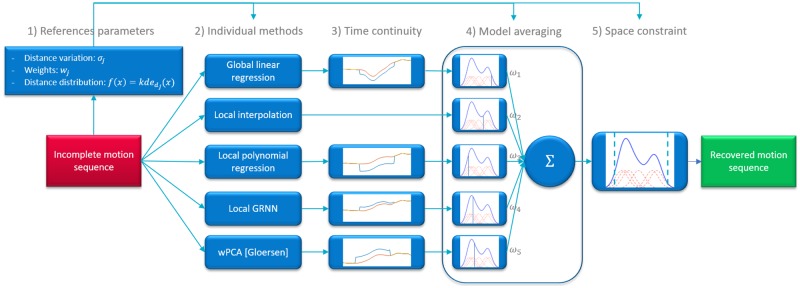
Block diagram of the proposed method.The overall process can be divided in five steps: 1) Extraction of marker trajectories parameters. 2) Individual recovery models. 3) Time constraint: trajectory continuity. 4) Distance-probability weighted averaging. 5) Spacing constraint: reference marker distance likelihoods.